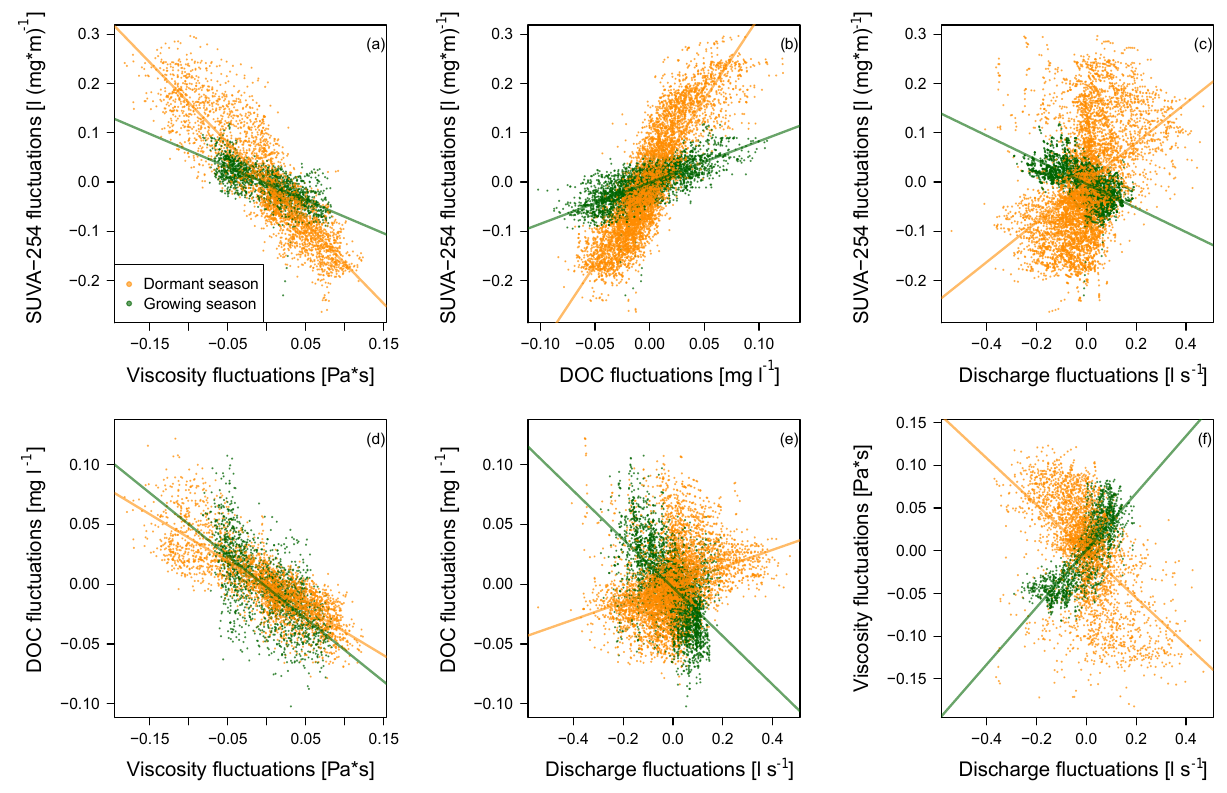
Figure 4. Scatterplots and linear regression between the 15min anomalies of the four variables for the growing and dormant period. Only rainless days with diel fluctuations and without the influence of rainfall–runoff events are shown (corresponding to the days in Fig.